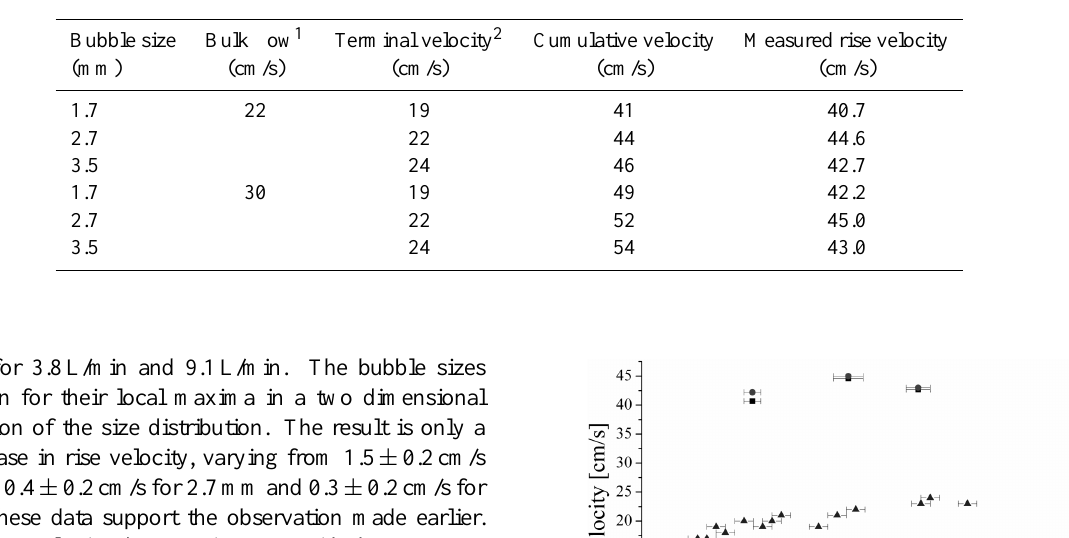
Table 3. For each bubble diameter the terminal velocities by Haberman & Morton 2 is added to the fluid velocity determined by Whalley & Davidson 1 and compared with the measured values.